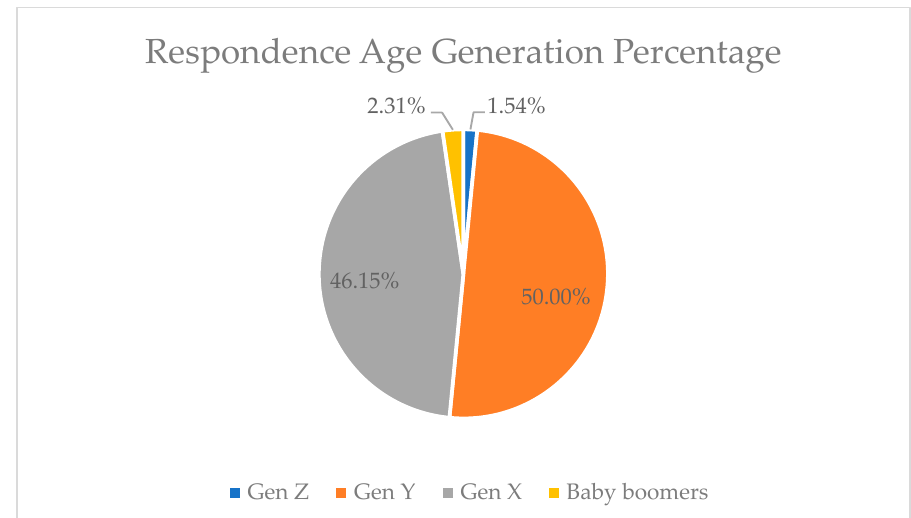
Figure 5. The Percentage of age generation.